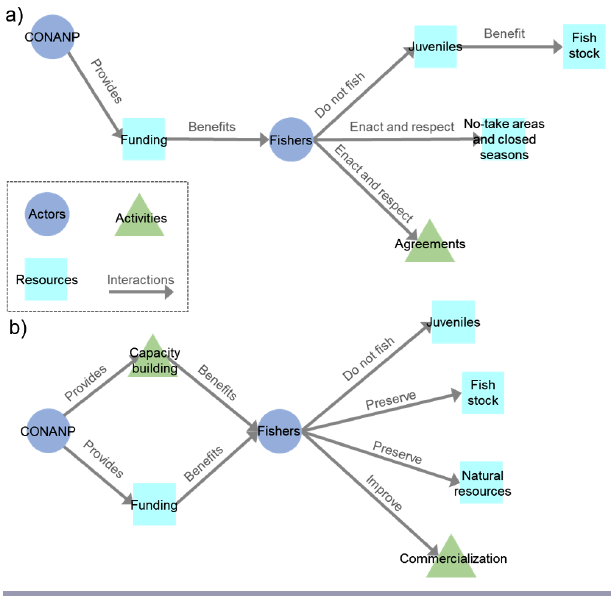
Fig. 6 . Group mental model of members of two fishing cooperatives: (a) La Palma and (b) El